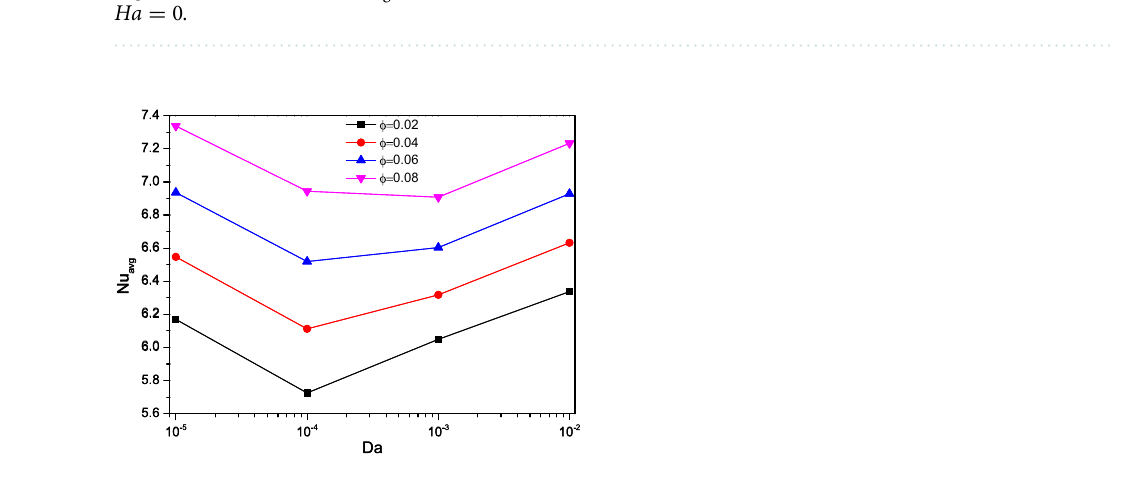
Figure 16. Variations of Nu avg with Da for diverse φ when Ra = 10 6 , ω = 0 , ε = 0.2 , N = 4 , r = 0.1 and Ha = 0 .